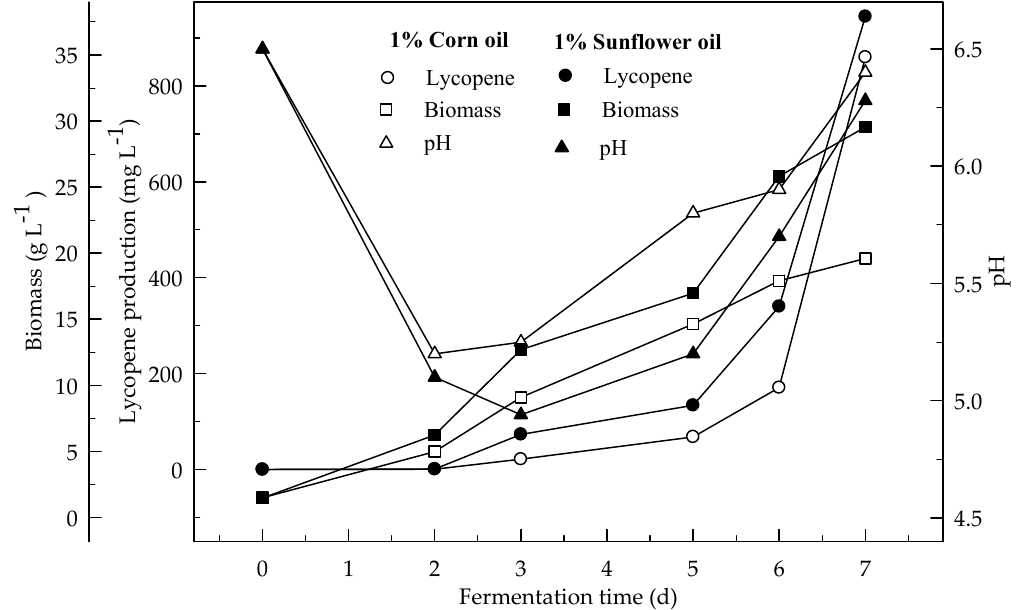
Figure 8. Changes in lycopene production, biomass formation and pH in a fermentor with an initial pH 6.5 in a 4% glucose fermentation medium 1% corn and sunflower oils (at aeration 3 L min − 1 with 500 rpm agitation).